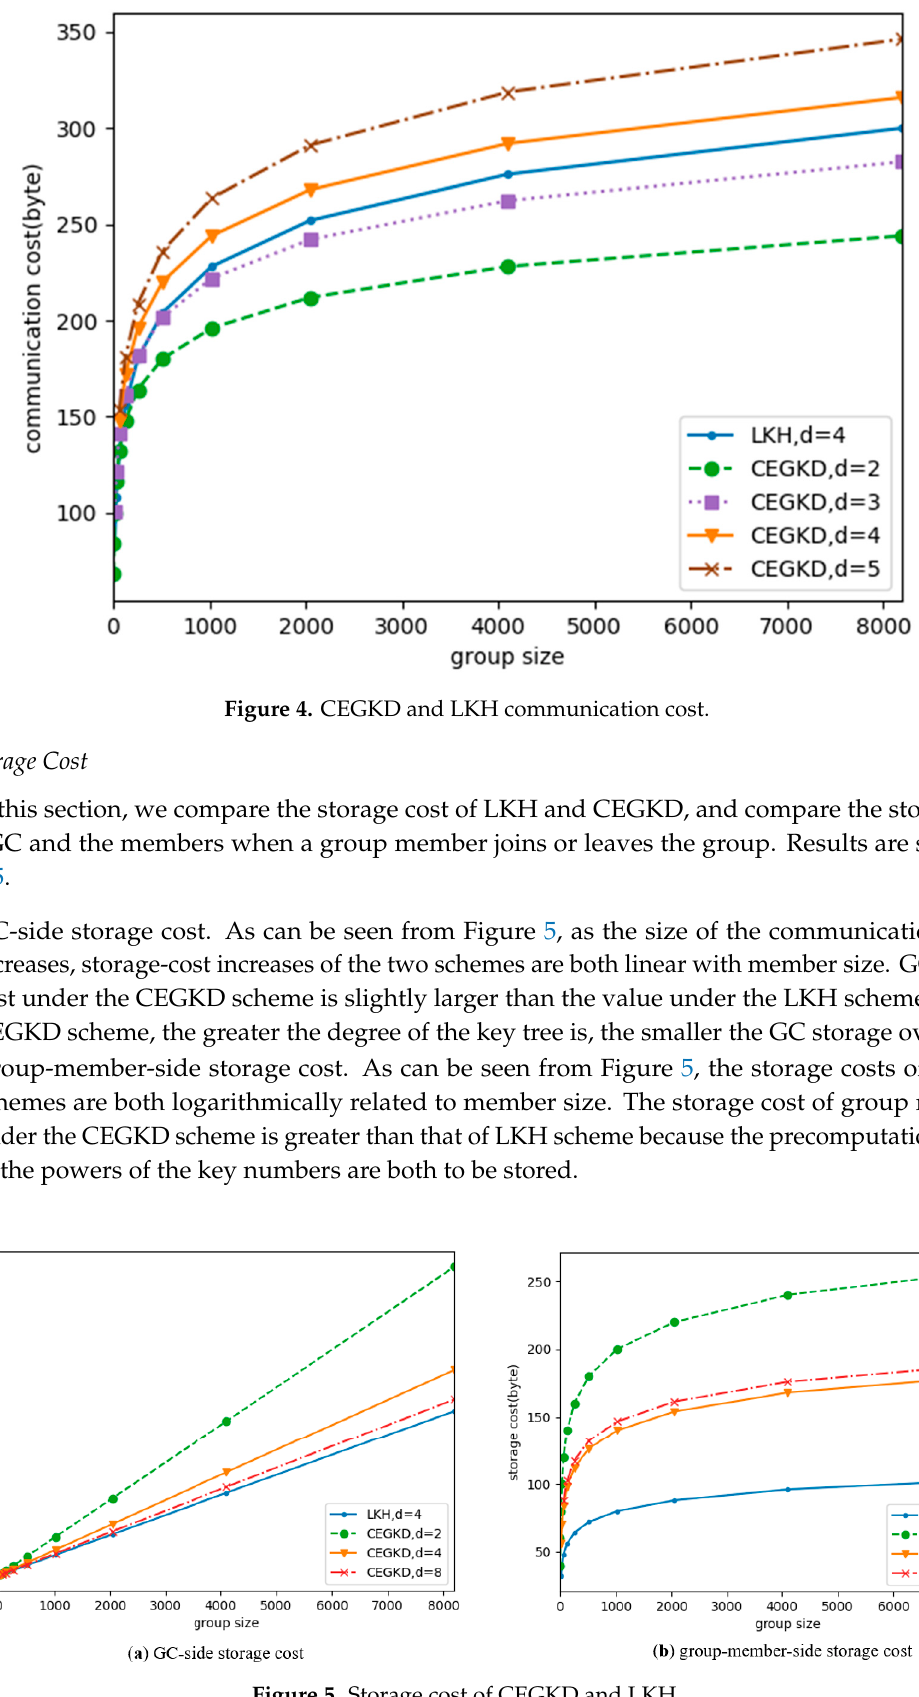
Figure 5. Storage cost of CEGKD and LKH.